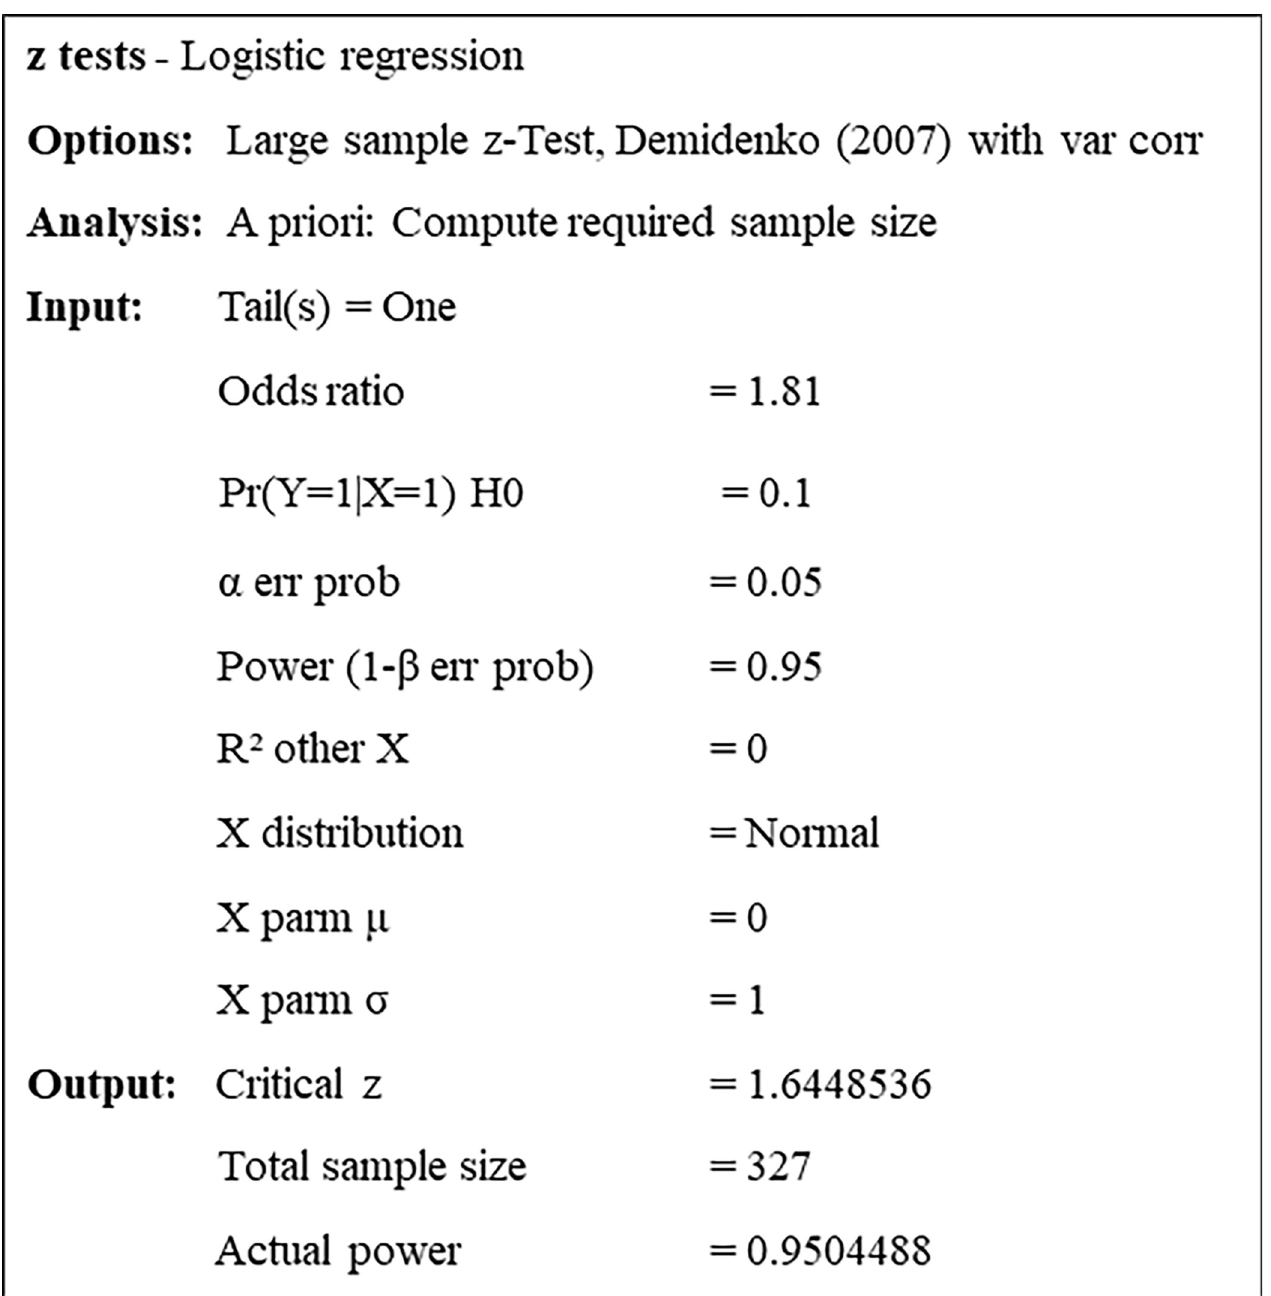
Fig 1. Parameters used to calculate the sample size based on a power